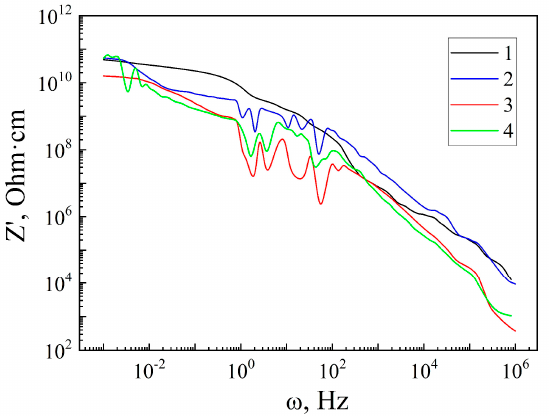
Figure 2. XRD diffraction patterns of: (1) MSM-41 matrices, and (2) MSM-41<SFA encapsulate.